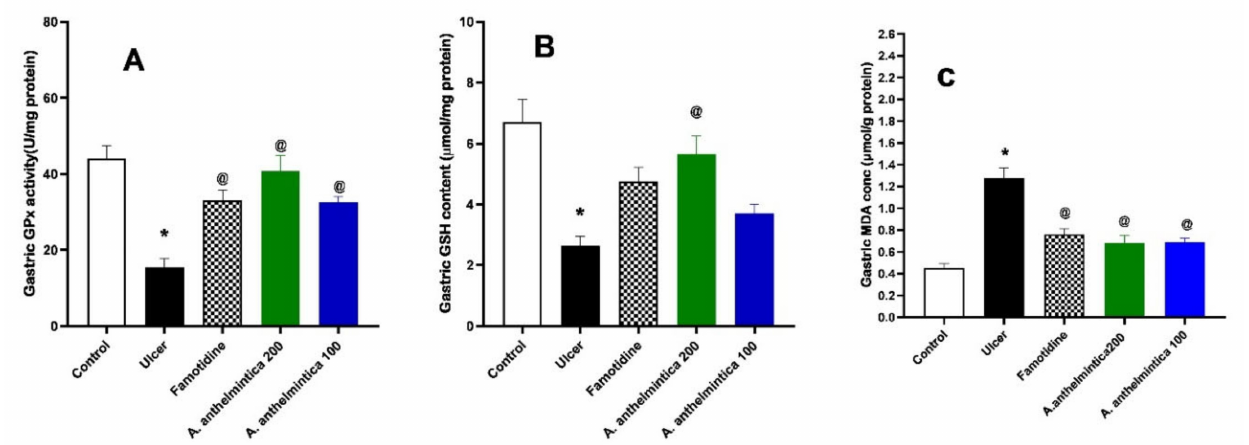
Figure 6. Effects of indomethacin alone and with oral administration of famotidine, or A. anthelmintica extract (200, 100 mg/kg) on ( A ) gastric glutathione peroxidase activity (GPx), ( B ) gastric reduced glutathione (GSH), and ( C ) lipid peroxidation product (malondialdehyde) in rats. Statistical analyses were carried out by one-way ANOVA followed by Tukey’s post hoc test, n = 6, mean ± SEM. * Significantly different from control group at p < 0.05. @ Significantly different from indomethacin alone group at p <